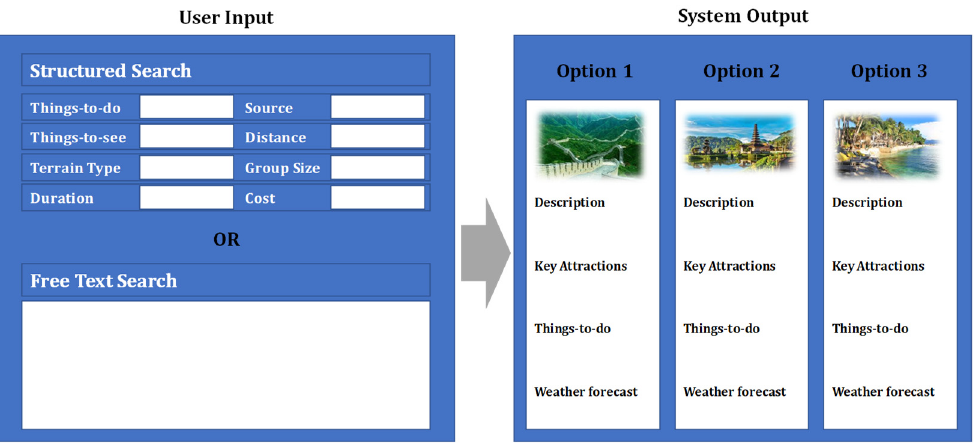
Figure 24. User input and system output of thematic TRS.